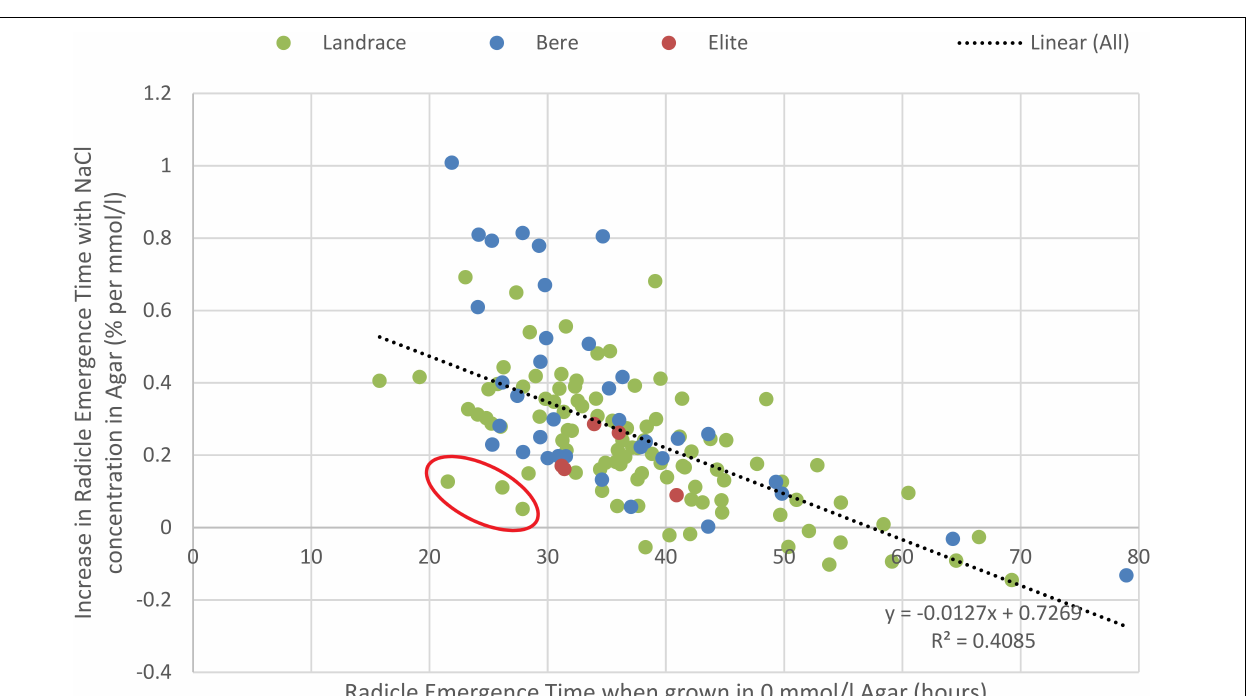
Frontiers in Plant Science |